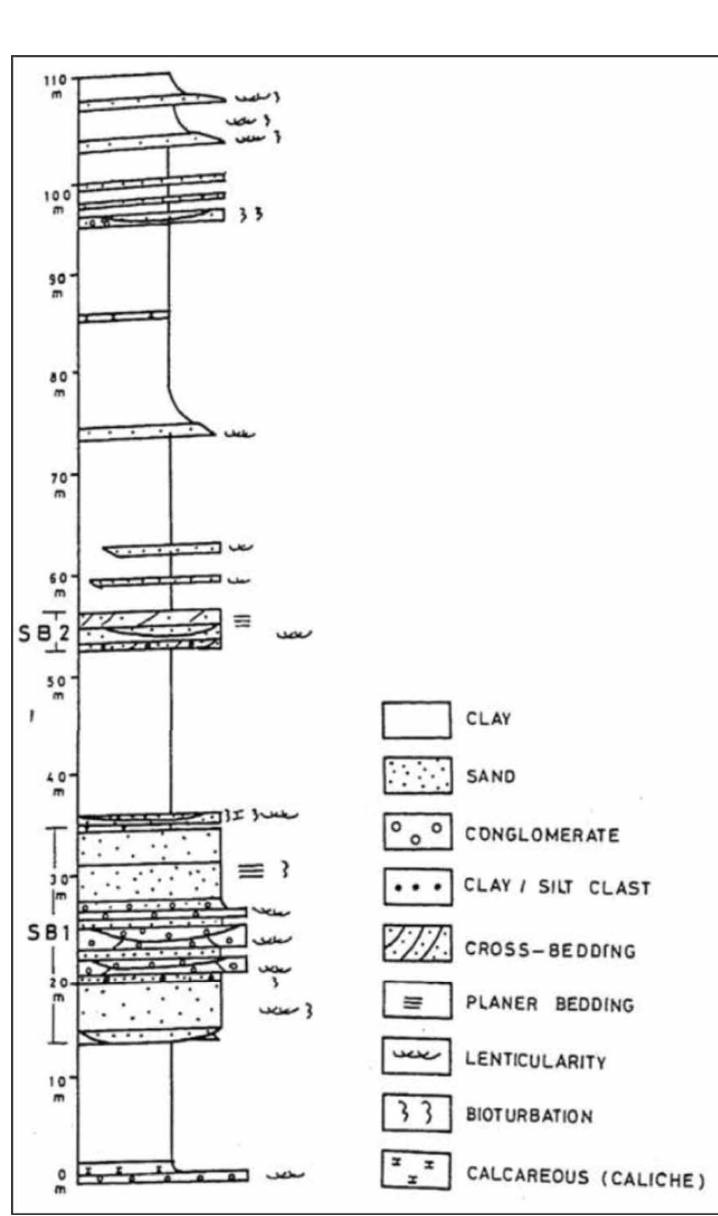
Figure 1. Stratigraphic column of the Murree Formation, Pakistan [13].